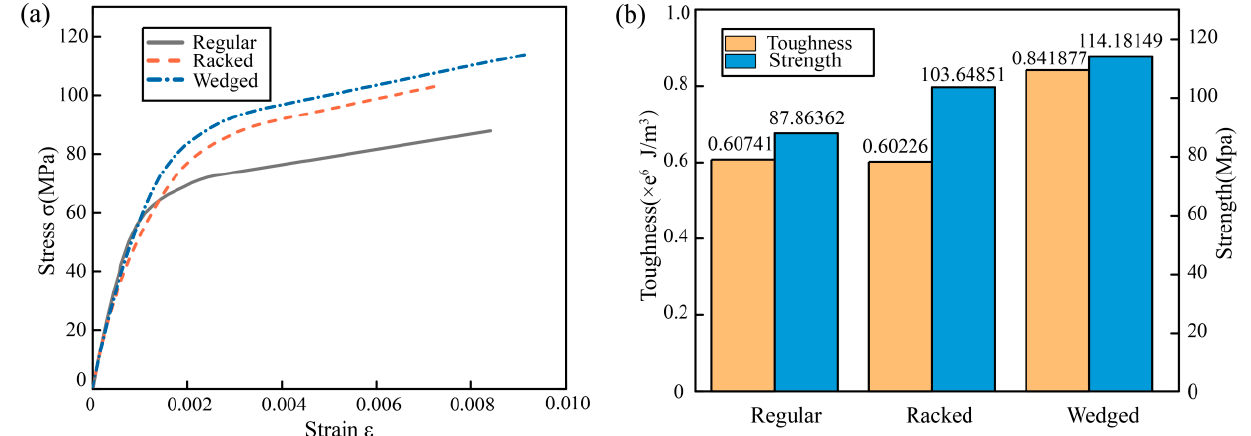
Figure 5. Tensile simulation results of different morphological models: ( a ) stress-strain curves, ( b ) Strength and toughness.